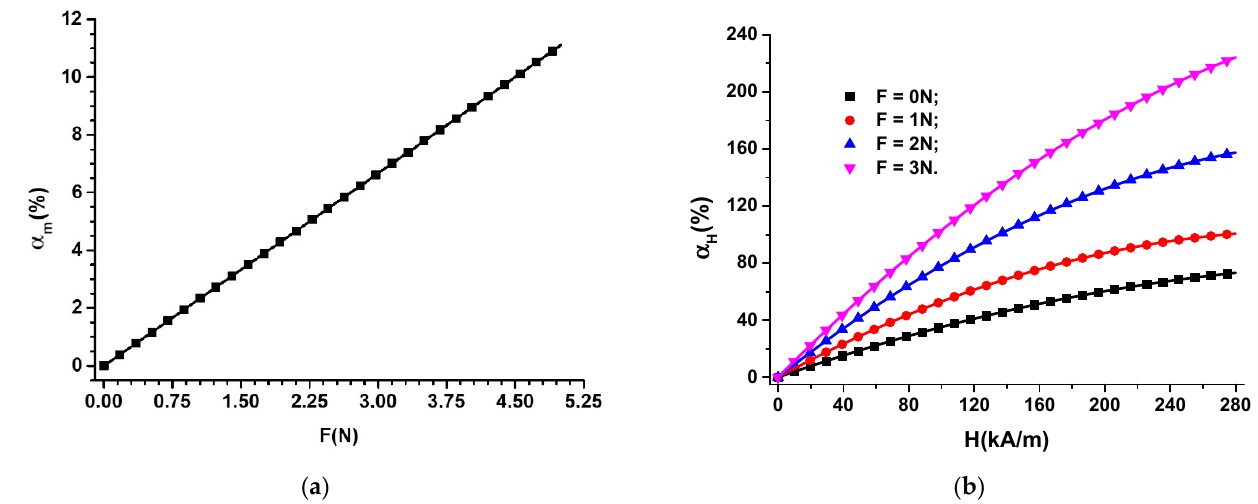
Figure 15. ( a ) The variation of α (cid:2890) as a function of the deformation force, F; ( b ) the contribution α (cid:2892) Figure 15. ( a ) The variation of α F as a function of the deformation force, F; ( b ) the contribution α H as as a function of the magnetic field intensity, H, for the deforming force, F, as a parameter. a function of the magnetic field intensity, H, for the deforming force, F, as a parameter. It is observed from Figure 15a that 𝛼 (cid:3007) increases linearly with F values. For F = 5 N, In Equation (4), we introduce the functions C Hm = C Hm ( H ) from Figure 14a, and we F we obtain 𝛼 (cid:3007) = 11.11% . obtain the function α H = α H ( H ) , as in Figure F